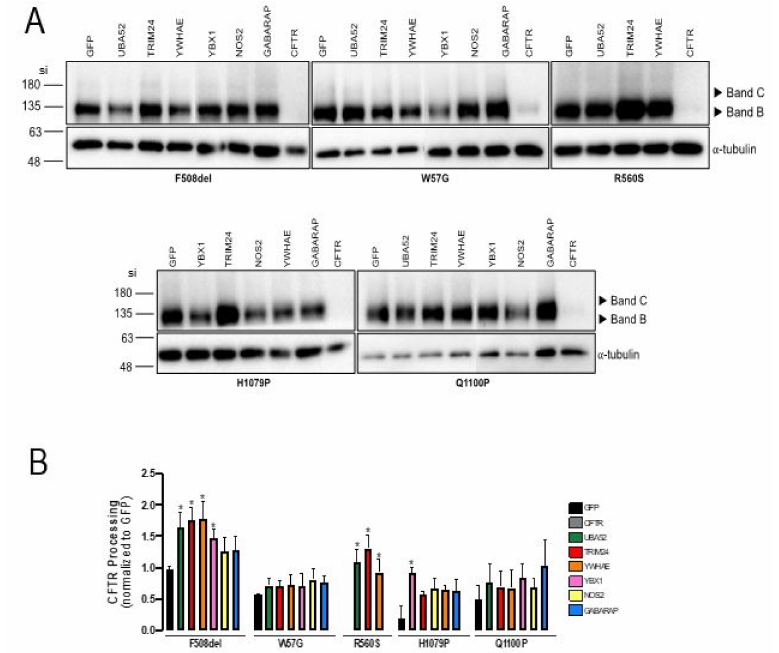
Figure 3. Effect of KD of selected genes in the rescue of W57G-, R560S-, H1079P- and Q1100P-CFTR folding defect. CFBE cells stably expressing W57G-, R560S-, H1079P-, Q1100P- and F508del- CFTR were transfected with siRNAs targeting 6 hit genes selected from the literature. ( A ) Representative WB analysis of CFBE cells reversely transfected with siRNAs targeting the hit genes ( n = 4). ( B ) CFTR processing (Band C/Band B + Band C) was normalized to siRNA GFP (negative control). Aster- isks indicate significant difference compared with GFP (* p -value < 0.05, unpaired t test). Images were acquired using ChemiDoc XRS+ imaging system BIO-RAD and processed using Image